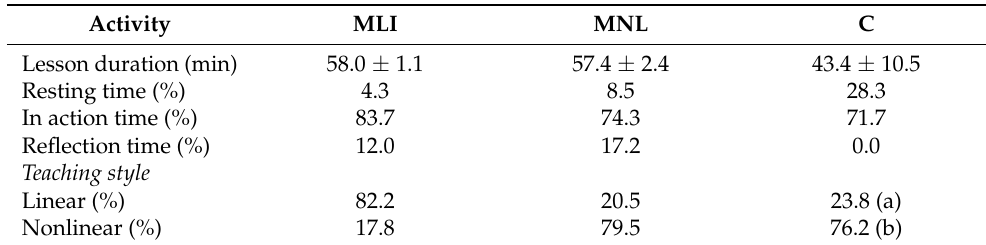
Table 3. Duration of activities and percentage differences between teaching approaches, as measured by physical education lesson video analysis with